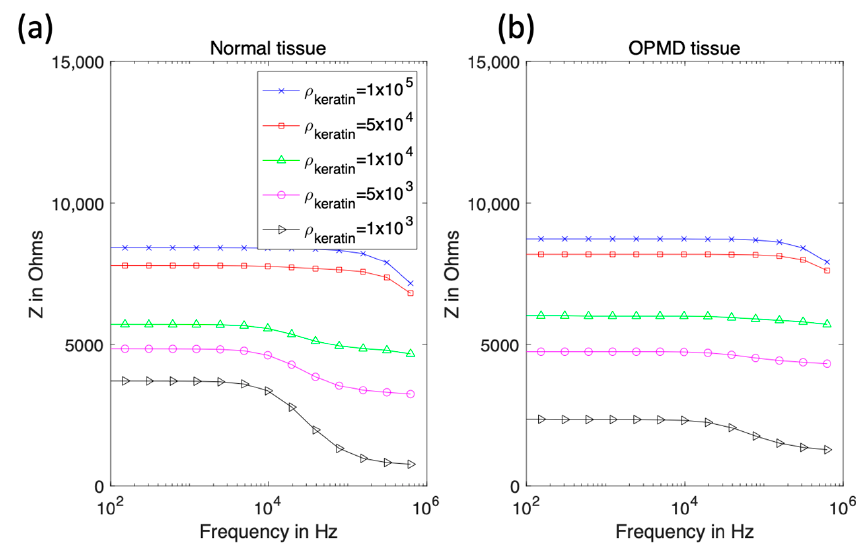
Figure 7. Real impedance spectra for keratinised normal ( a ) and OPMD ( b ) tissue with varying ke- ratinised layer resistivity.